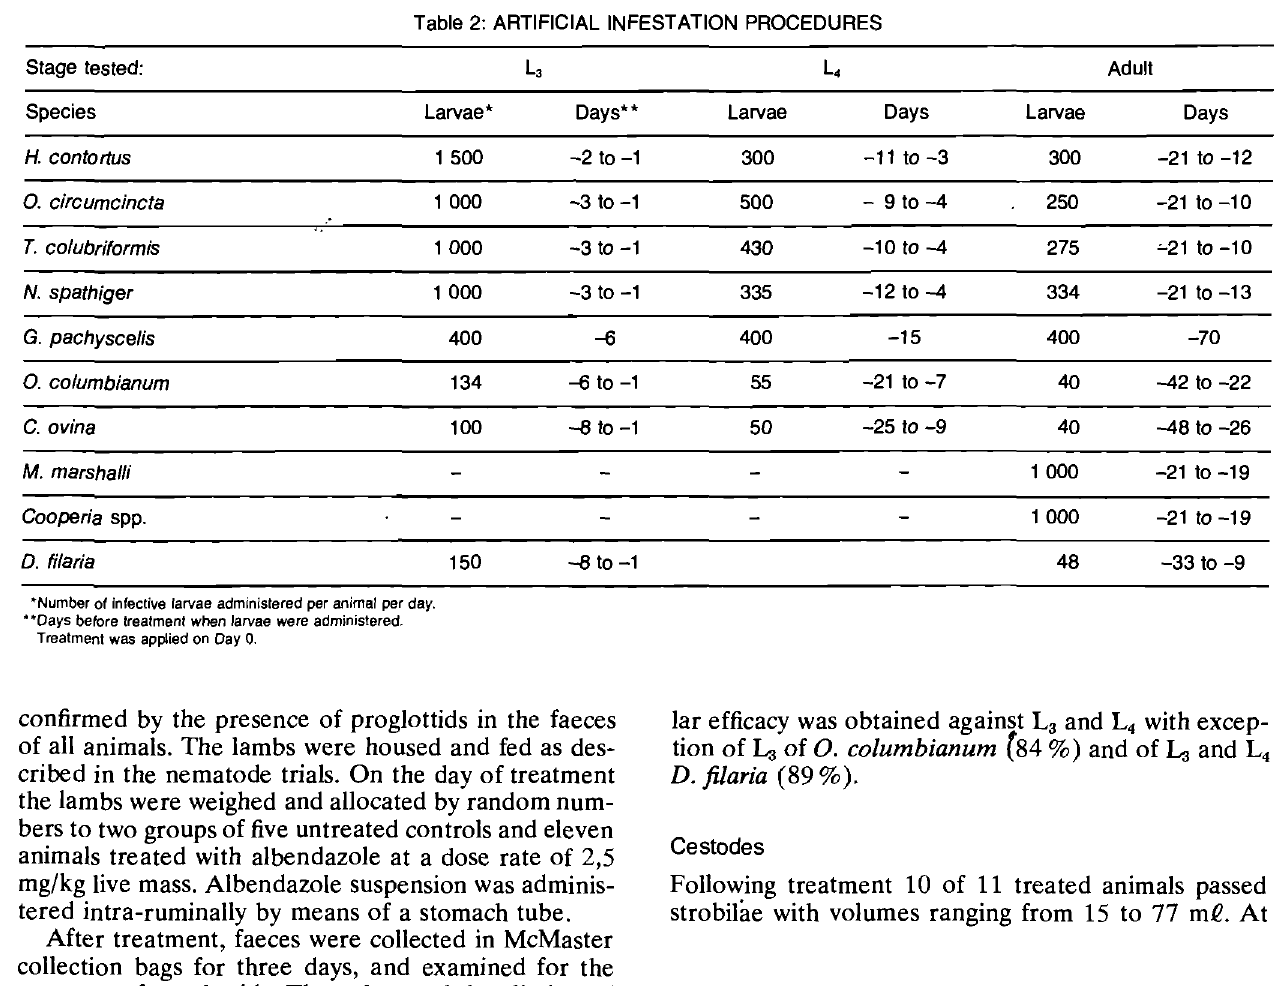
Table 3: WORMS RECOVERED AND EFFICACY OF